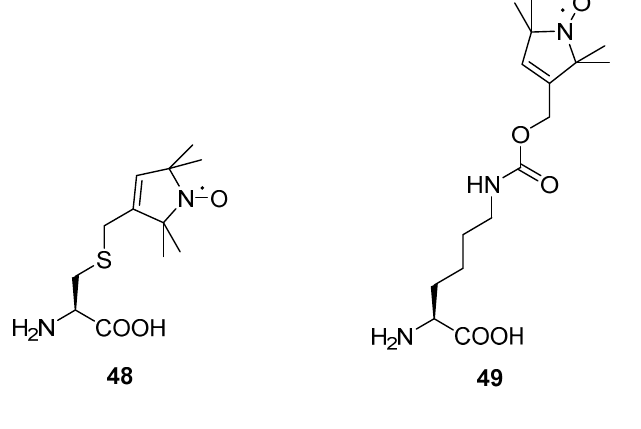
Figure 13. Paramagnetic unnatural amino acids 48 and 49